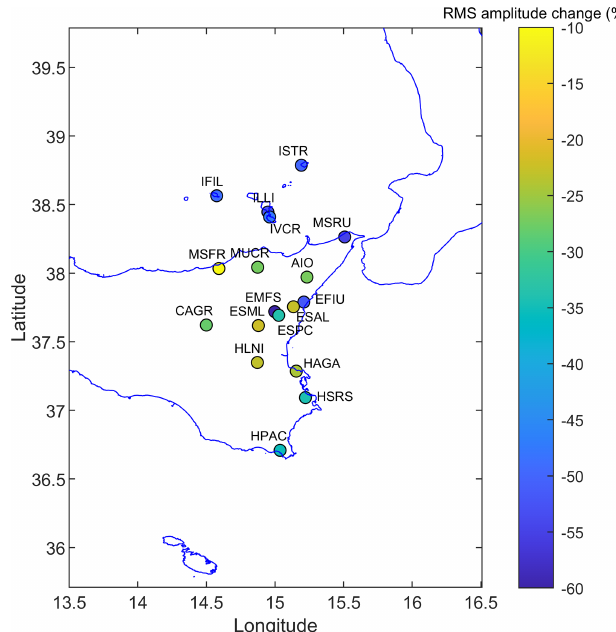
Figure 5. Percent change in seismic rms amplitude in the band 10– 40Hz during the period 11 March–11 April 2020 (right after the lockdown measures entered into force) with respect to the interval 20 January–20 February